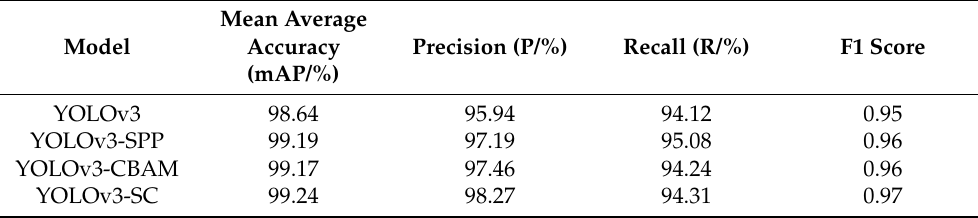
Table 5. Comparison of YOLOv3-SPP and YOLOv3-CBAM with